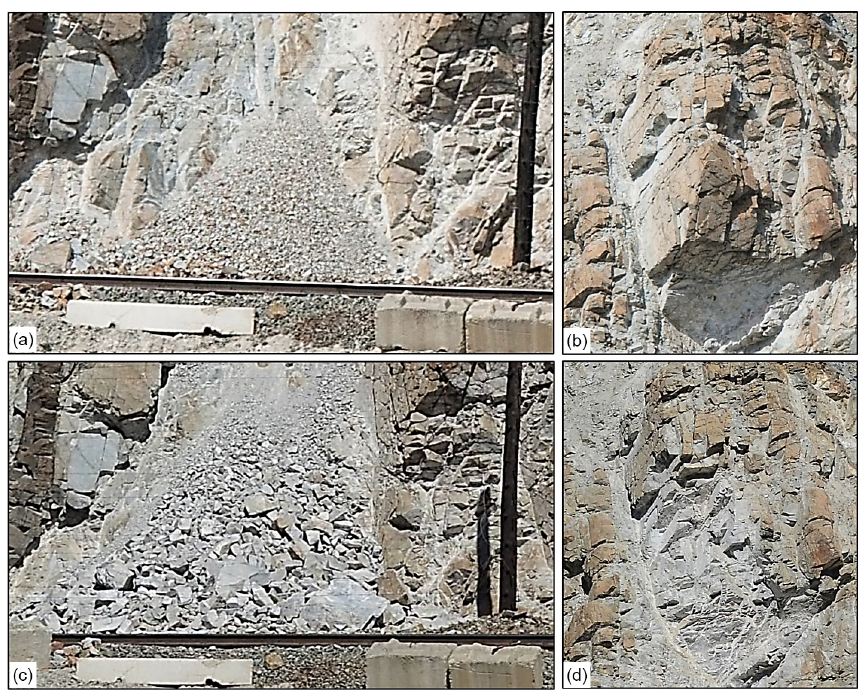
Figure 8. Before and after photos of the 24m 3 wedge sliding event from White Canyon East, Site B. The top row of photos shows the pre-fall debris present in the track-side ditch (a) , as well as the pre-fall source zone (b) . The bottom row shows the post-fall accumulation in the track-side ditch (c) , as well as the post-fall source zone (d) . From these images we can see the heavily jointed state of the rockfall mass pre-fall and the rockfall back scarp post-fall. A notable increase in the quantity and size of debris fragments in the track-side ditch is visible post-fall.